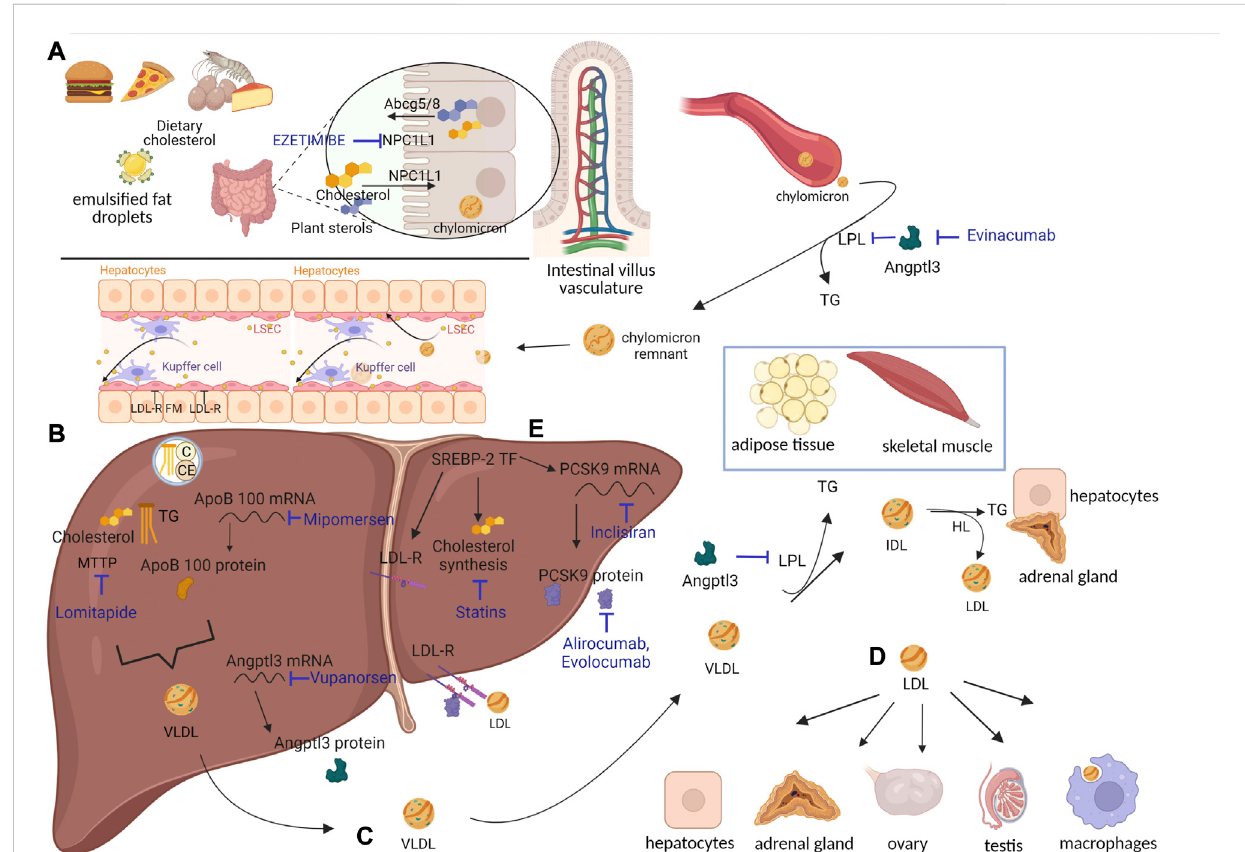
FIGURE 1 Lipoprotein metabolic processes and cholesterol-lowering drugs. (A) Cholesterol assumed from diet reaches enterocytes through NPC1L1. There, cholesterol esters (CEs) and triglycerides (TGs) are packaged into chylomicrons (CMs). Once in circulation, CMs are deprived of most of their TGs, which aredeliveredtoadiposetissueandskeletalmusclethroughtheactionoflipoproteinlipases(LPLs).CMsturnintoCMremnants,whichaccesshepatocytes through LDL-R and LDL-R family members (FMs). (B) Cholesterol contained in CM remnants can be used by hepatocytes or packaged in VLDL and secreted into circulation. SREBP-2 transcription factor is responsible for synthesis of i) cholesterol, ii) LDL-R, and iii) PCSK9 (see also Figure 2). (C) VLDLs are deprived of most TGs, delivered to adipose tissue and skeletal muscle through action of LPL, and turned into IDL. IDL can either access hepatocytes through LDL-R and LDL-R FM or be converted into LDL by hepatic lipases (HLs). (D) LDL can be internalized by hepatocytes or move to districts particularly dependent on cholesterol for hormonal synthesis, like adrenal glands and gonads. LDL can also be phagocytosed by macrophages, which, in thecaseofLDLoverload,appearasfoamcells.Cholesterol-loweringdrugs,inhibitingdifferenttargets,havebeendeveloped(writteninblue).Speci fi cally, ezetimibe inhibits NPC1L1, evinacumab inhibits ANGPTL3, mipomersen inhibits ApoB100 (at RNA level), lomitapide inhibits MTTP, vupanorsen inhibits ANGPTL3 (at RNA level), inclisiran inhibits PCSK9 (at the RNA level), alirocumab – evolocumab inhibits PCSK9, and statins inhibit cholesterol synthesis. Created with BioRender.com. (E) SREBP-2 transcription factor induces cholesterol synthesis and the expression of LDL-R and